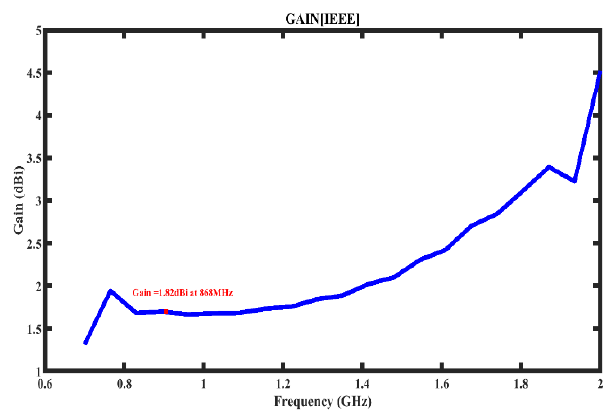
Fig.7. Simulated input impedance Vs Frequency /GHz of proposed RFID antenna.